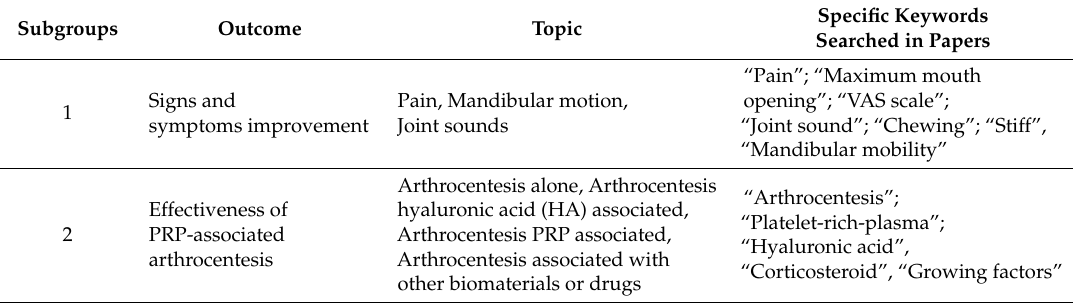
Table 3. Advanced and specific search.